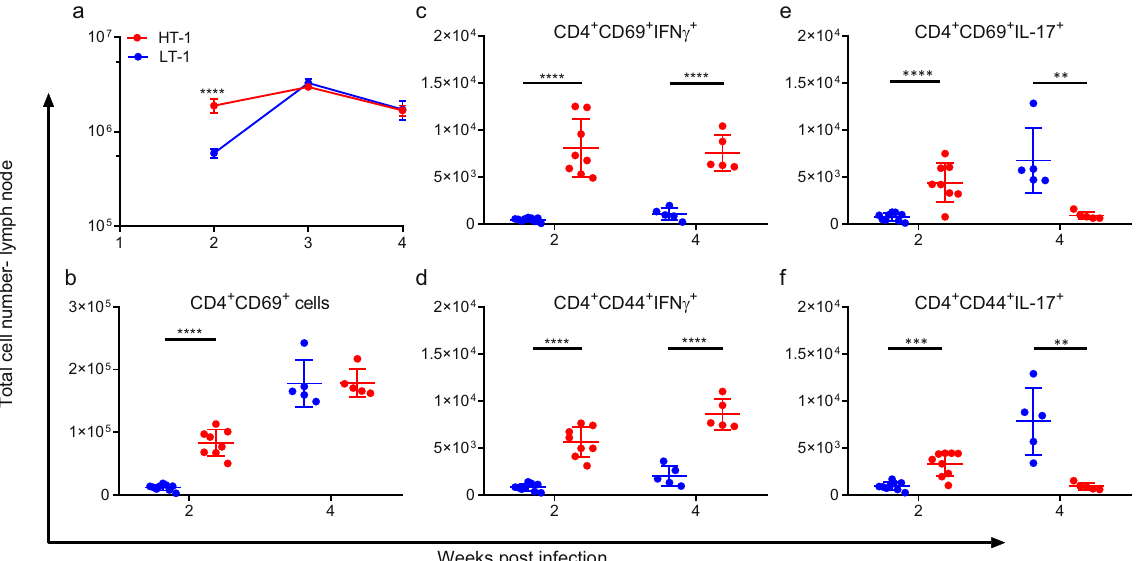
Fig. 2 Increased dissemination in conjunction with early Th1 priming in the lymph nodes of Mtb-HT infected mice. C3HeB/FeJ mice were infected with ~100 CFU of the indicated strain via Glas-Col aerosol exposure. At the indicated time post infection mice were sacri fi ced and mediastinal lymph nodes were isolated. Single cells were stimulated for 3 h with Mtb-H37Rv lysate and mycobacterial ESAT-6 and CFP-10 peptide pools and stained with a panel of cell surface antibodies, fi xed and permeabilized, and then stained with a panel of intracellular antibodies. Cellular recruitment to the lymph node presented as absolute number ( a ) and percent of activated CD4 + T cells in the lymph nodes ( b ) was evaluated in Mtb-LT1 and Mtb-HT1 infected mice at weeks 2, 3, and 4 post infection. Percent of CD69 + ( c ) and CD44 + ( d ) CD4 + T cells expressing IFN γ + and percent of CD69 + ( e ) and CD44 + ( f ) CD4 + T cells expressing IL-17 evaluated in the lymph nodes at weeks 2 and 4 post infection. Data are presented as mean values + / − SD. Source data are provided as a Source Data fi le. Sample size of n = 8 mice were included for 2-week time point and n = 5 mice for week 3 and 4 time points. Signi fi cance was determined using two-way ANOVA with Bonferroni post-test ( a ) and unpaired t test ( b – f ). ** P = 0.0026 in panel ( e ), ** P = 0.0056 in panel ( f ), *** p < 0.001, **** p < 0.0001. The experiment was repeated with Mtb-HT2 and Mtb-LT2. cells were maintained in Mtb-HT1 at 4 weeks of infection, there was nonetheless a marked contraction of IL-17 + T cells (Fig. 2e, f). In stark contrast, in Mtb-LT1 infection, IL-17 expressing CD4 + T cells increased and were signi fi cantly higher in comparison to Mtb-HT1 infection (Fig. 2e, f). Together, the data so far indicate that there is not only a delay, but also a phenotypic difference in the T cell response in Mtb-LT1 infected mice compared to Mtb-HT1 infected mice. This fi nding estab- lishes that in Mtb-LT infection, the delayed Mtb dissemination to the lymph nodes does not result in complete suppression of T cell activation and differentiation, but instead it is later skewed towards Th17 dominant response. NATURE COMMUNICATIONS| (2022) 13:884 |https://doi.org/10.1038/s41467-022-28506-2|www.nature.com/naturecommunications